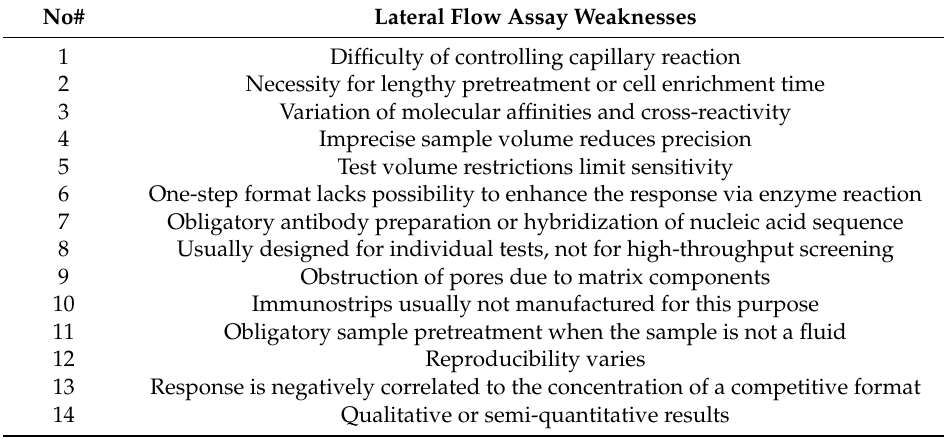
Table 3. Restrictions and weakness of lateral flow assays, summarized by Posthuma-Trumpie [89] and Sajid [90]. No# Lateral Flow Assay